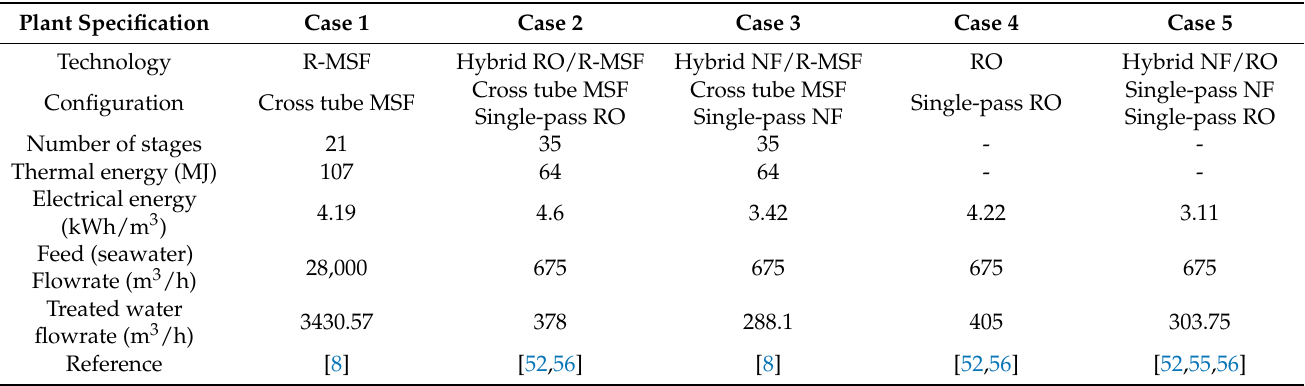
Table 1. Plant configuration and energy demand of the cases 1–5.